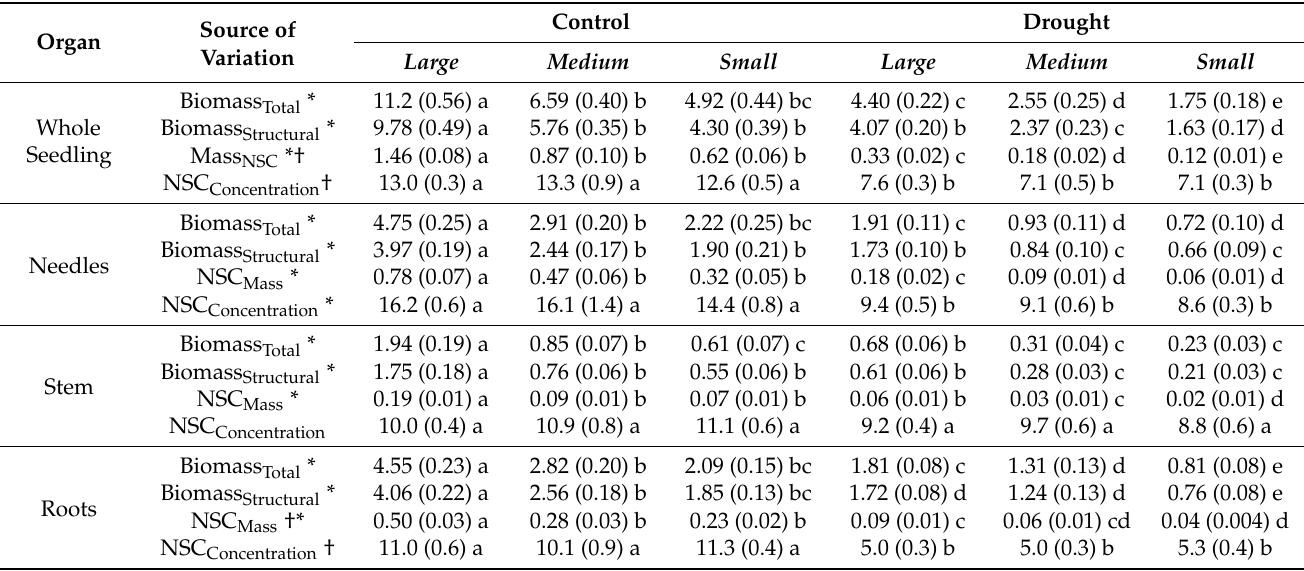
Table A4. Summary of final measurement means ( ± SE) seedling for pine seedlings by seedling type and drought interaction. Biomass Total is the sum of structural and NSC mass. Different letters within a row indicate significant differences according to Tukey’s HSD ( p <